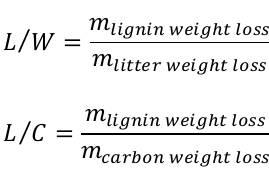
and 40% (at 20ºC and low HM) (Figure 2a-c), which corresponded to decomposition rates between 0.0016 day -